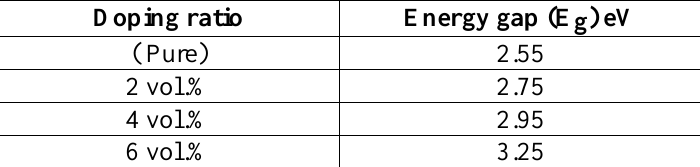
Table 3: The optical energy gap average for CdO